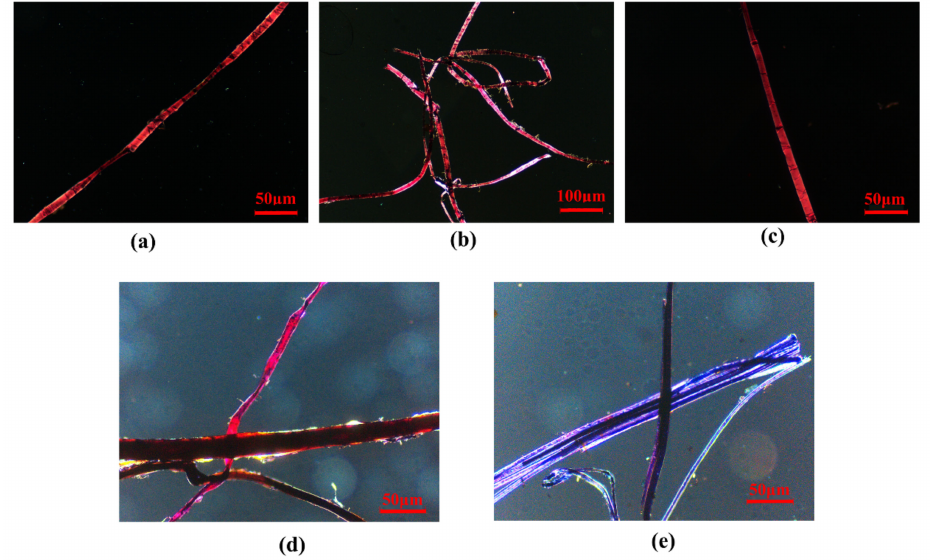
Figure 6. Morphology of paper fibres: ( a ) XSBD-F1; ( b ) XSBD-F2; ( c ) XSND-F4; ( d ) XSND-F5; ( e )